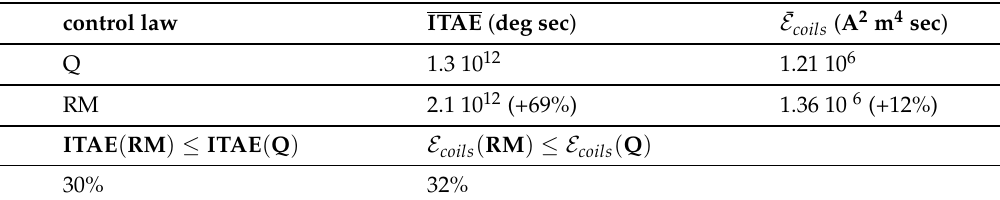
Table 5. Statistics of the Monte Carlo campaign for the perturbed case. control law